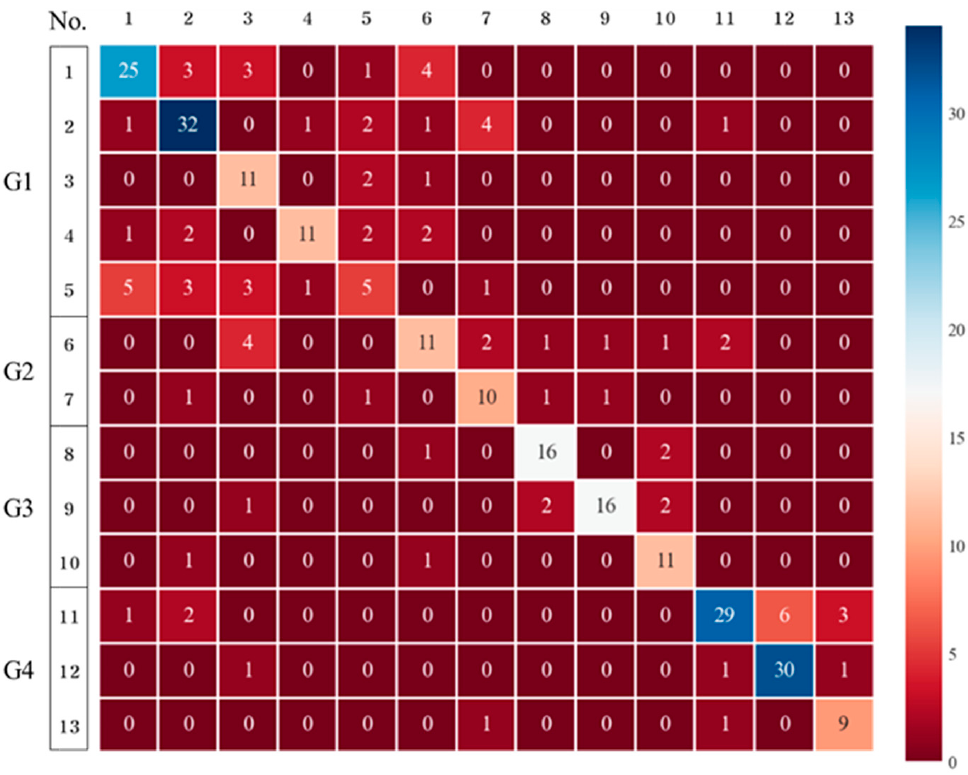
Figure 4. Confusion matrix (classi fi cation of the 13 chemicals using decision trees).